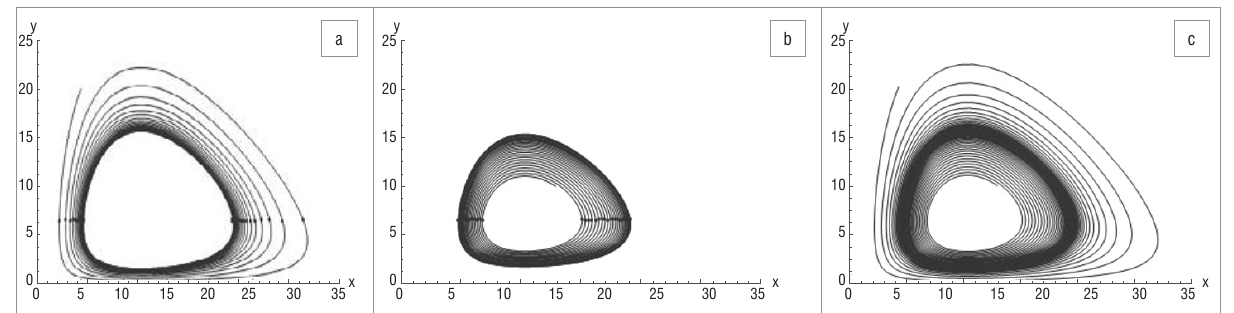
Figure 7: Illustration of points of intersection of the Poincaré section L : y = 6.6 and a solution of System 1B initiated (a) from outside of the limit cycle, (b) from inside the limit cycle and (c) when both trajectories converge to the same limit